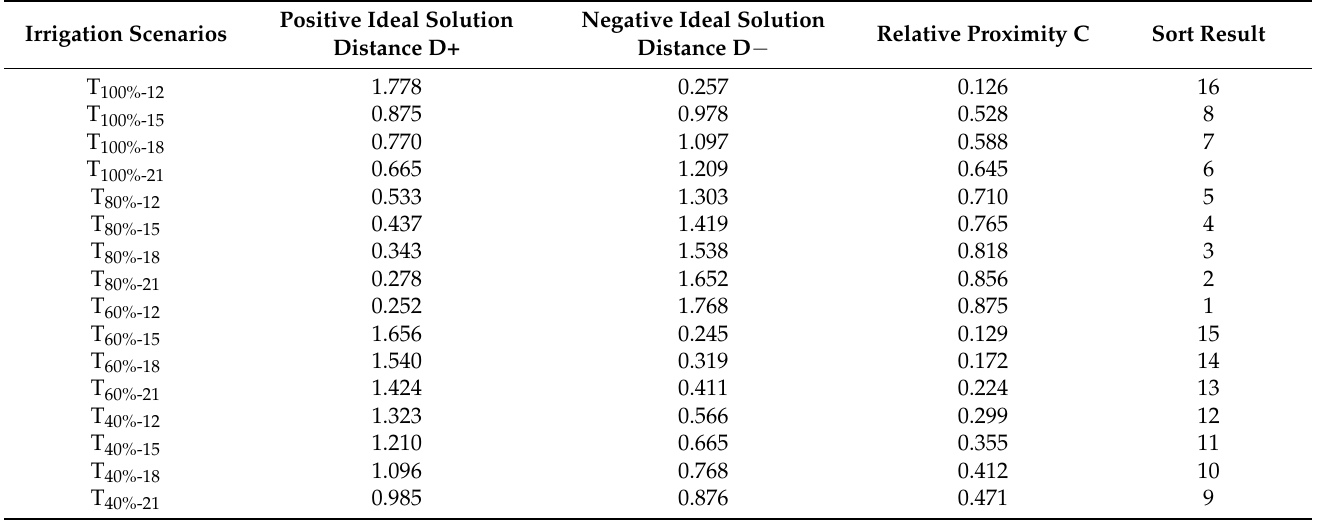
Table 3. TOPSIS evaluation calculation